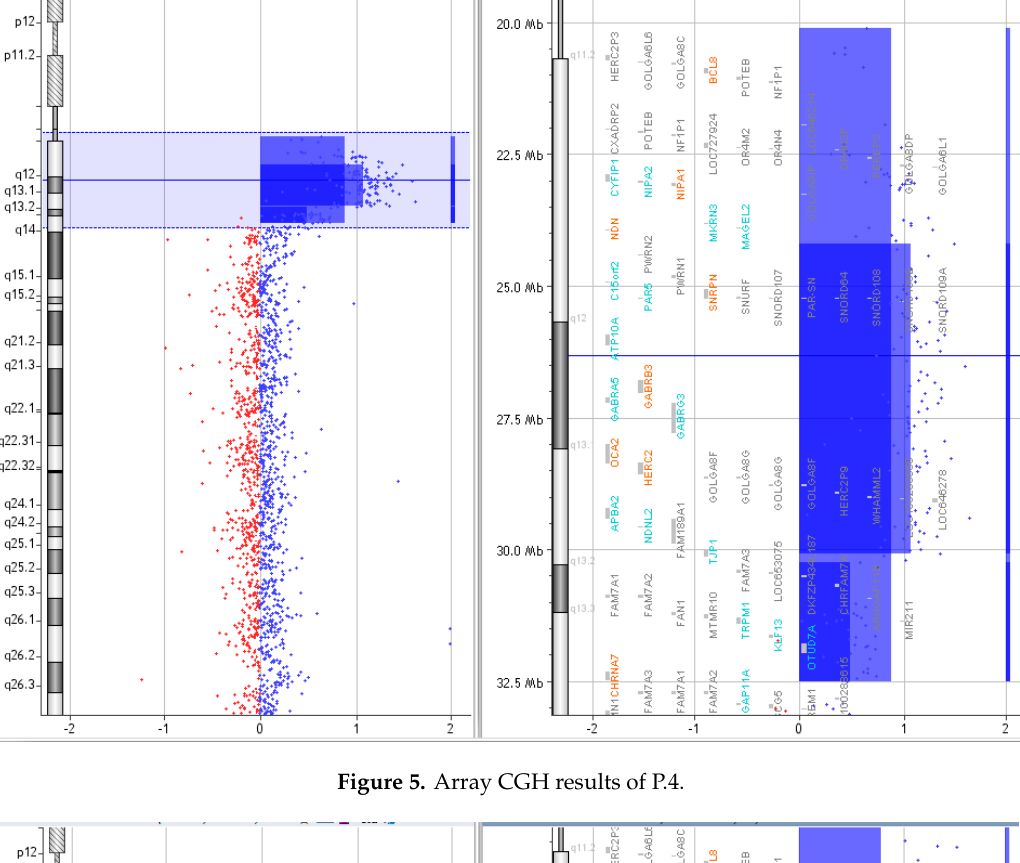
Figure 5. Array CGH results of P.4.